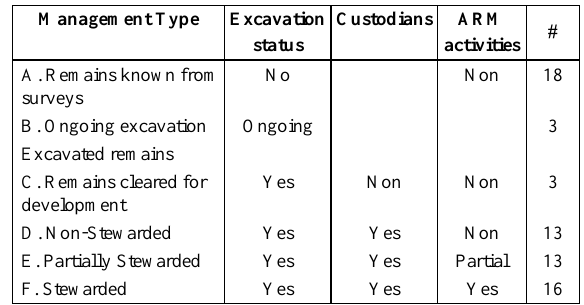
Table 1. Site classification by management